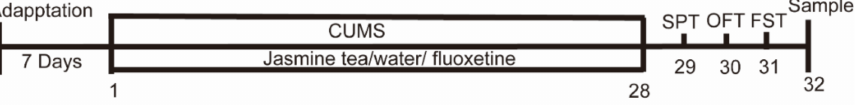
Figure 1. The schematic diagram of the experiment. CUMS Rats were treated with jasmine tea/green tea/water/fluoxetine during the 4 weeks. After 4 weeks of treatment, fresh feces were collected, and then a battery of behavioral tests relevant to depression was undergone. The rats were sacrificed on day 32. Tissues were collected to analysis in further. CUMS, chronic unpredictable mild stress; SPT, sugar preference test; OFT, open field test; FST, forced swim